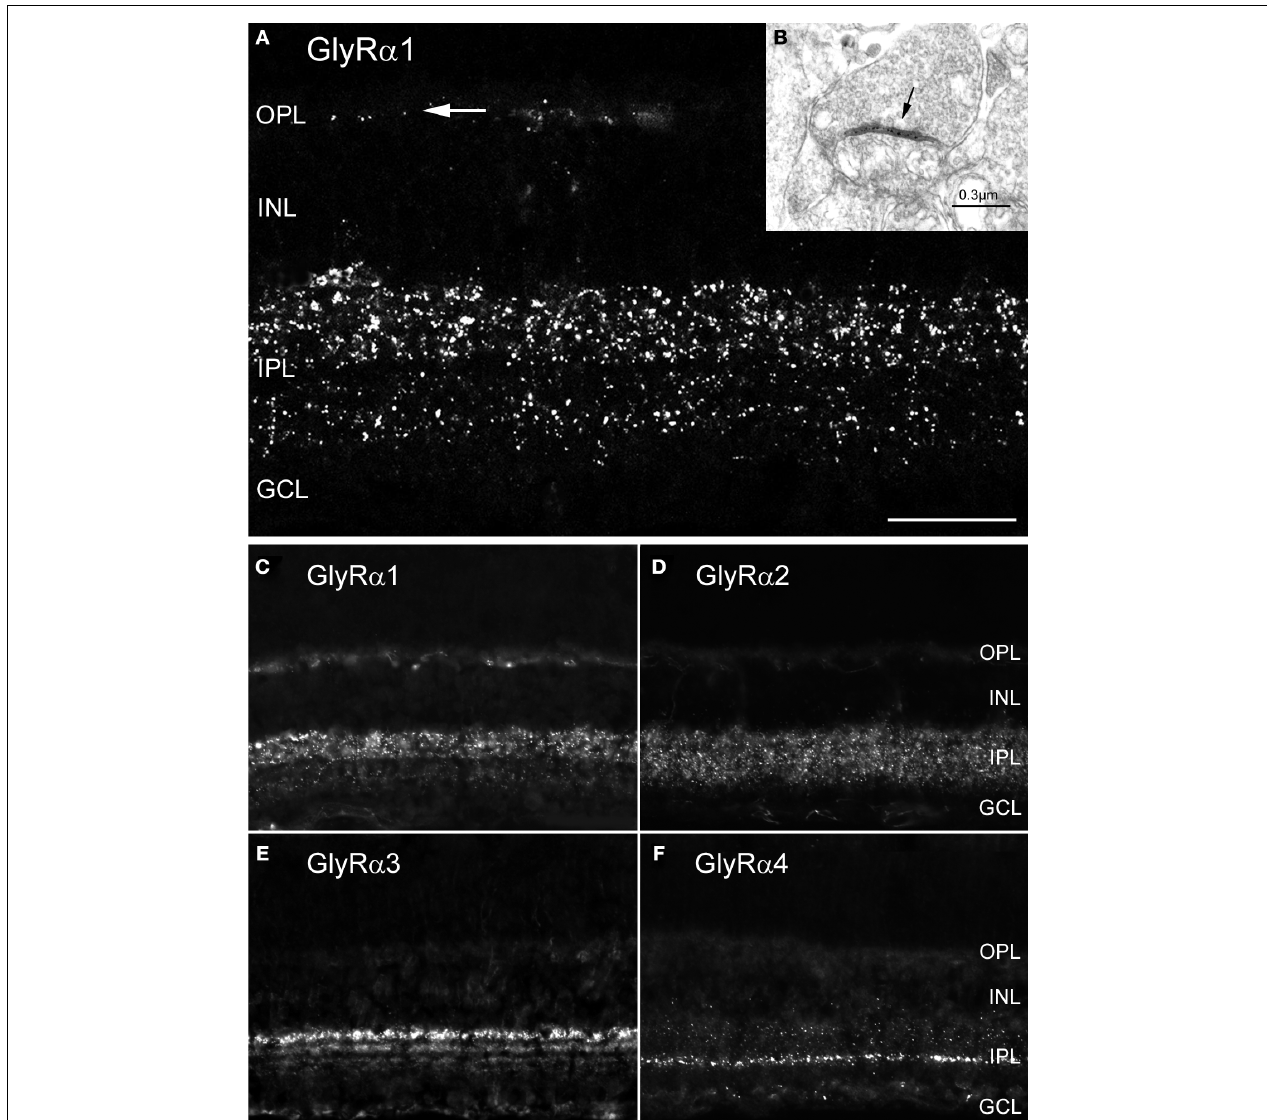
FIGURE 3 | Synaptic localization of GlyR subtypes in the rodent retina (modifi ed from Heinze et al., 2007; Sassoè-Pognetto et al., 1994). (A) Fluorescence micrograph of a vertical section through a rat retina that was immunostained for the GlyR α 1 subunit. The arrow points to a few synaptic clusters in the OPL. (B) Electron micrograph showing a synapse (arrow) expressing the GlyR α 1 subunit. The antibody (mAb2b) recognises an